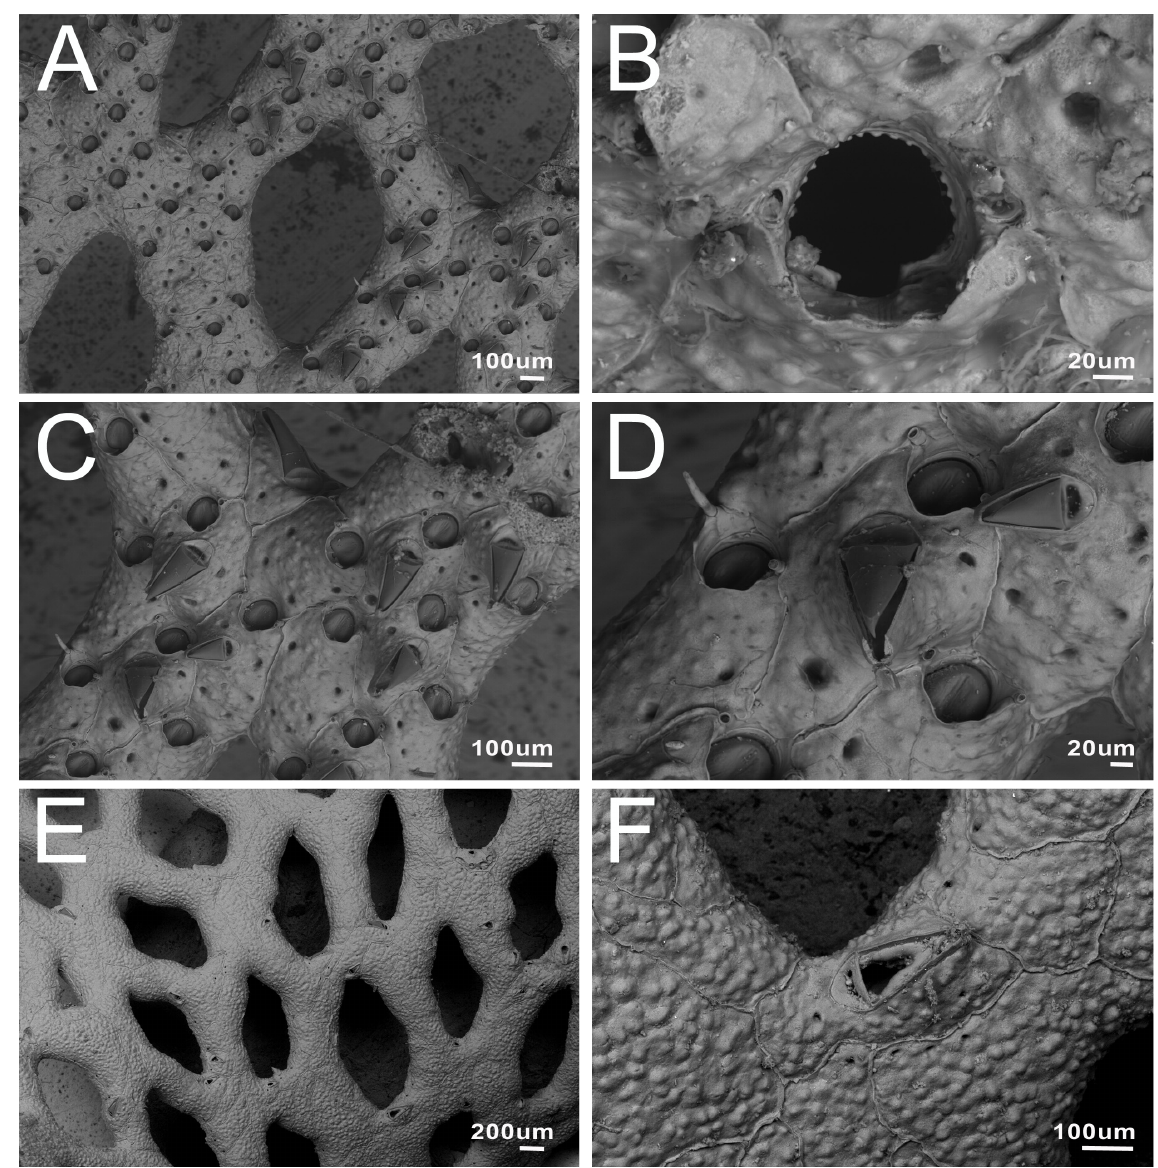
Fig. 11. Schizoretepora sp. nov. (= S. imperati sensu O’Donoghue & de Watteville 1939), from Schizoretepora imperati , coll. O’Donoghue (NHMUK 1963.9.4.12). A . Colony view. B . Primary orifice showing distal denticles and proximal condyles. C . Autozooids with giant avicularia. D . Large vicarious avicularia on cystid. E . Abfrontal view. F . Detail of abfrontal avicularium and rugose